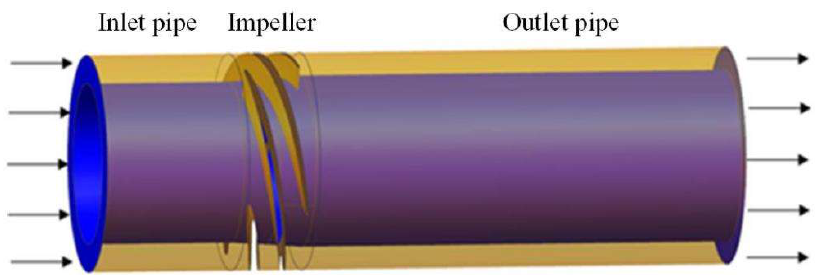
Figure 1. Three-dimension model of multiphase pump.